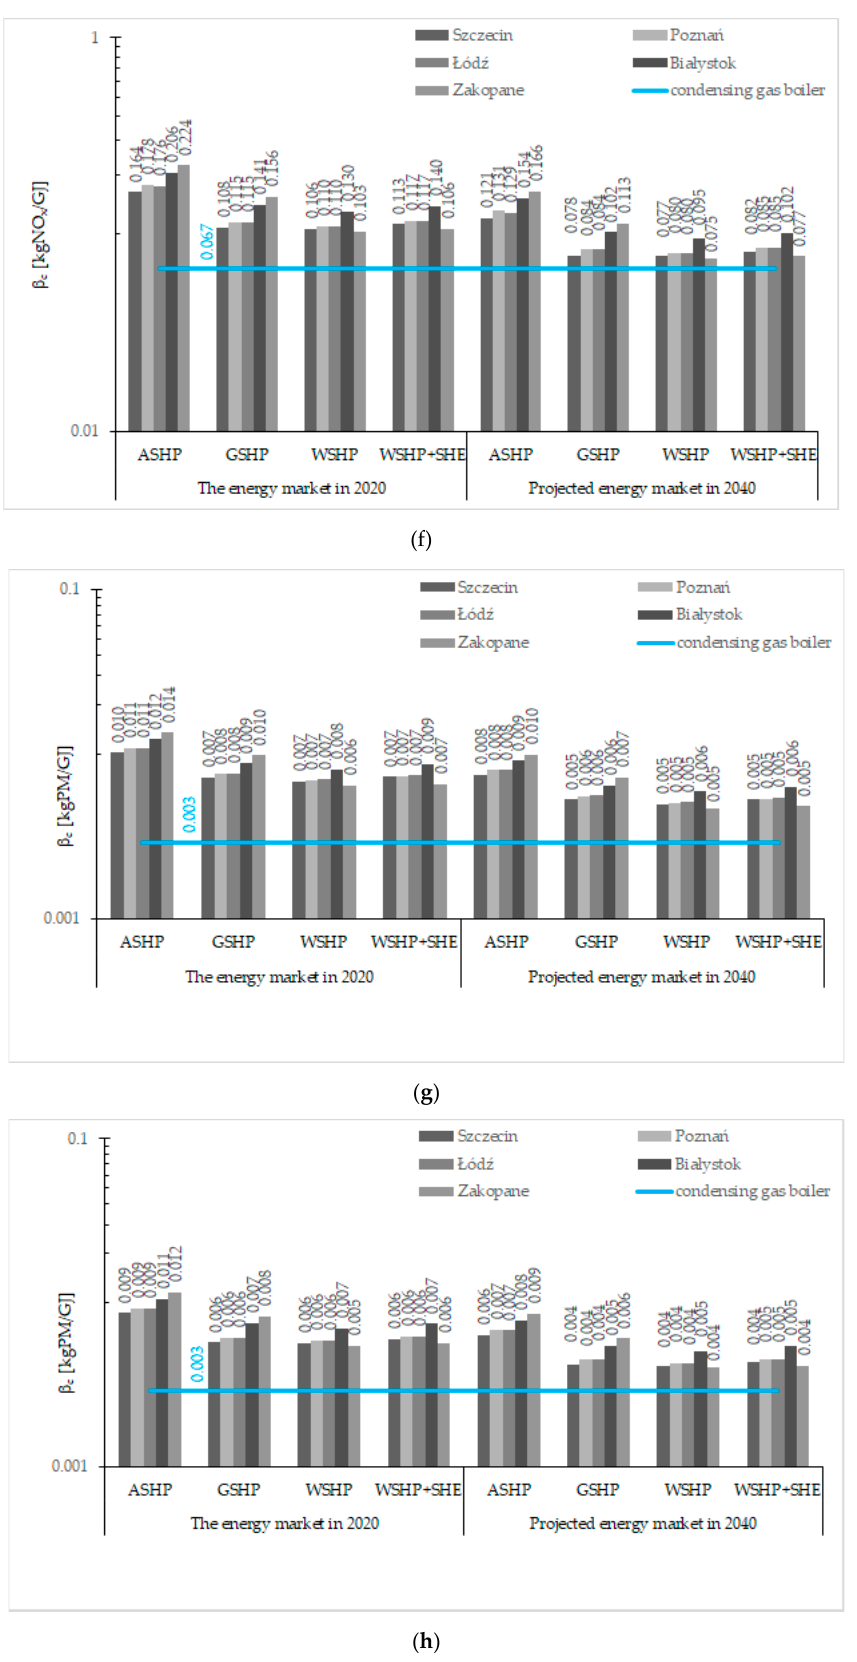
Figure 3. Unit emissions of greenhouse gases and particulate matter for the heat pumps in the specific locations as well as unit emissions of condensing gas boiler as the reference level: ( a ) carbon dioxide emissions at a constant temperature in the buffer tank; ( b ) carbon dioxide emissions with changed temperature in the buffer tank; ( c ) sulfur dioxide emissions at a constant temperature in the buffer tank; ( d ) sulfur dioxide emissions with changed temperature in the buffer tank; ( e ) nitro- gen oxide emissions at a constant temperature in the buffer tank; ( f ) nitrogen oxide emissions with changed temperature in the buffer tank; ( g ) PM emissions at a constant temperature in the buffer tank; ( h ) PM emissions with changed temperature in the buffer tank. Figure 3 shows that CO 2 emissions from the WSHP in the second variant in Zakopane would be less than from the condensing gas boiler if the second scenario was realized, which also includes an effect of 20.8% electrical power transfer losses. In other words, the indirect emissions levels are 1.26 times higher because of the transfer losses. To reduce all emissions from the heat pumps below the condensing gas boiler level in the whole of Poland, the Polish energy mix must vary very substantially. The results of the variation suggested in Table 9 are shown in Figure 4.